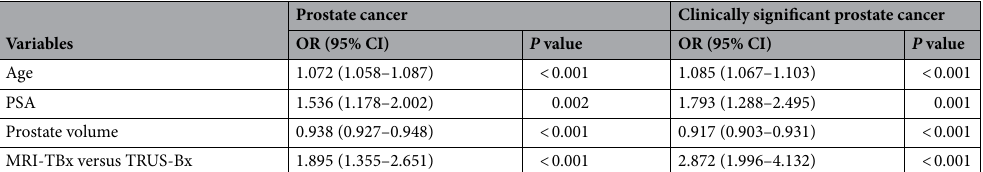
Table 3. Multivariate logistic regression analyses to determine the predictive factors for the detection of prostate cancer and clinically significant prostate cancer in men with low PSA levels (2.5–4.0 ng/mL). PSA Prostate-specific antigen, OR Odds ratio, CI Confidence interval, TRUS-Bx Transrectal ultrasound-guided biopsy, MRI-TBx Magnetic resonance imaging-targeted biopsy.